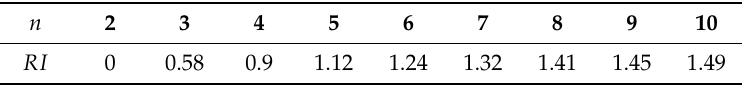
Table 1. Random Index (RI) for different values of n